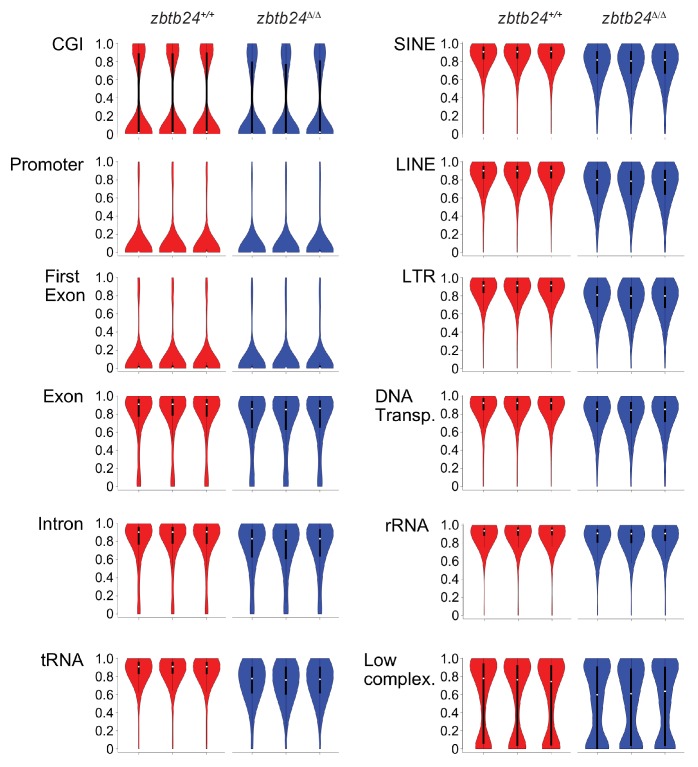
DNA Methylation levels at different genomic classes.Violin plots indicating CpG methylation in fins from adult zbtb24+/+ and zbtb24Δ/Δ zebrafish at various genomic classes. The annotations are based on CGI, Repeatmasker, and RefSeq (only ‘cmpl’ entries) tracks from the UCSC genome browser (DanRer7). Promoters are defined as the region ±500 bp around the TSS. All CpGs had coverage >= 10. DNA Transp.: DNA Transposons, Low complex.: Low Complexity.